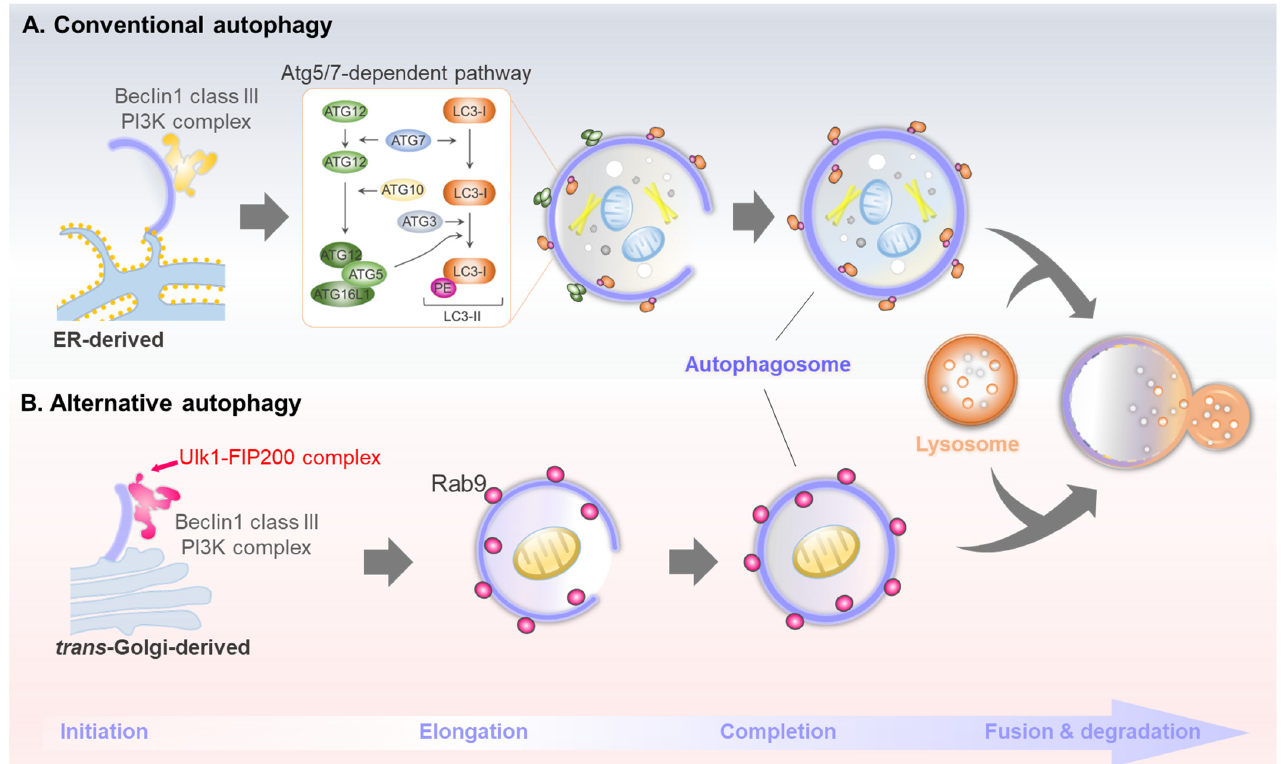
Figure 1. Brief molecular mechanisms of conventional and alternative autophagy. ( A ) Conventional autophagy is initiated by Ulk1/2, Beclin1 complex, and Atg5/7-dependent LC3 lipidation. ( B ) Alternative autophagy is initiated by Ulk1, Beclin1 complex, and Rab9-dependent autophagosome generation.